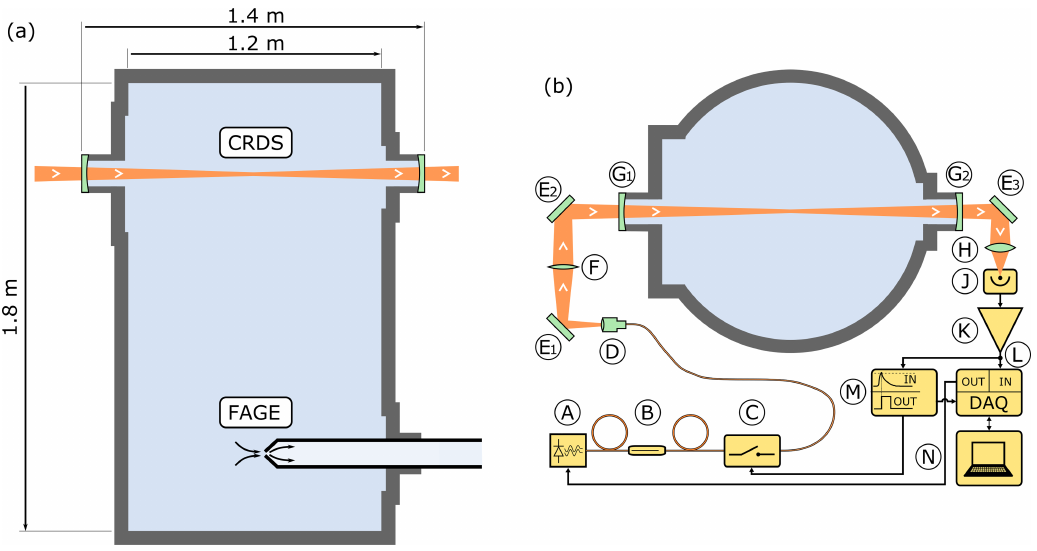
Figure 2. (a) Longitudinal (horizontal) section of HIRAC. The CRDS spectrometer probes the HO 2 concentration across the chamber’s diameter, while the FAGE instrument samples the atmosphere in the chamber at one point. (b) Cross section of HIRAC. [A] Fibre-pigtailed DFB laser diode and mount, [B] inline optical isolator, [C] acousto-optic modulator (AOM), [D] adjustable fibre collimator, [E1]–[E3] silver mirrors, [F] f = 250mm mode-matching lens, [G1]–[G2] high-reflectivity dielectric cavity mirrors, [H] f = 30mm focusing lens, [J] InGaAs photodiode, [K] transimpedance amplifier, [L] data acquisition unit, [M] latched comparator circuitry, [N] laptop running LabVIEW for data processing and